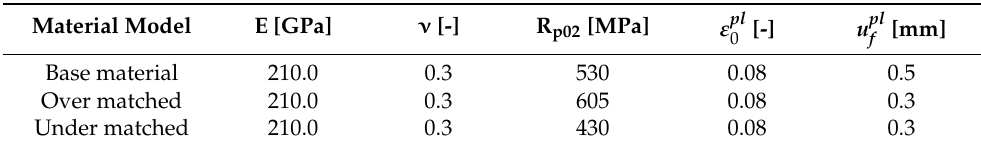
Figure 6. Model for FEM analysis with crack tip in the middle of the weld metal: ( a ) mesh of the entire model; ( b ) detailed mesh in the relevant area. Table 5. Material parameters for reference BM, OM and